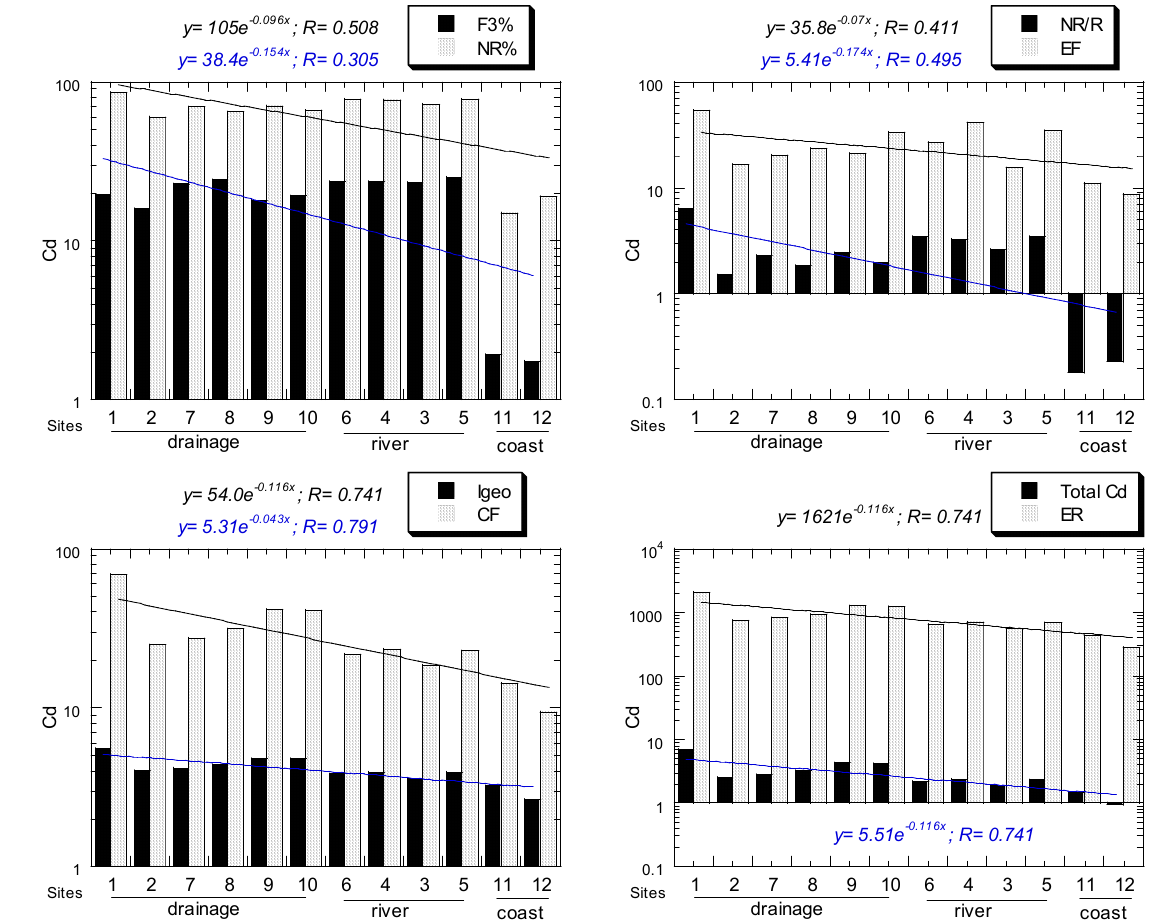
richment”. For Cu, all I geo values of all sites ranged from − 1.42, “practically unpolluted” to